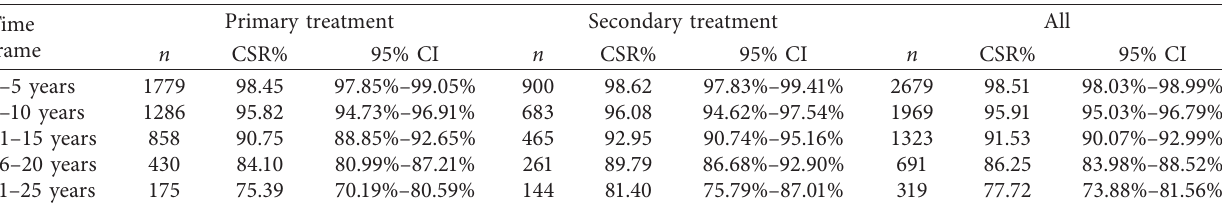
Table 2: Cumulative survival rate over time.